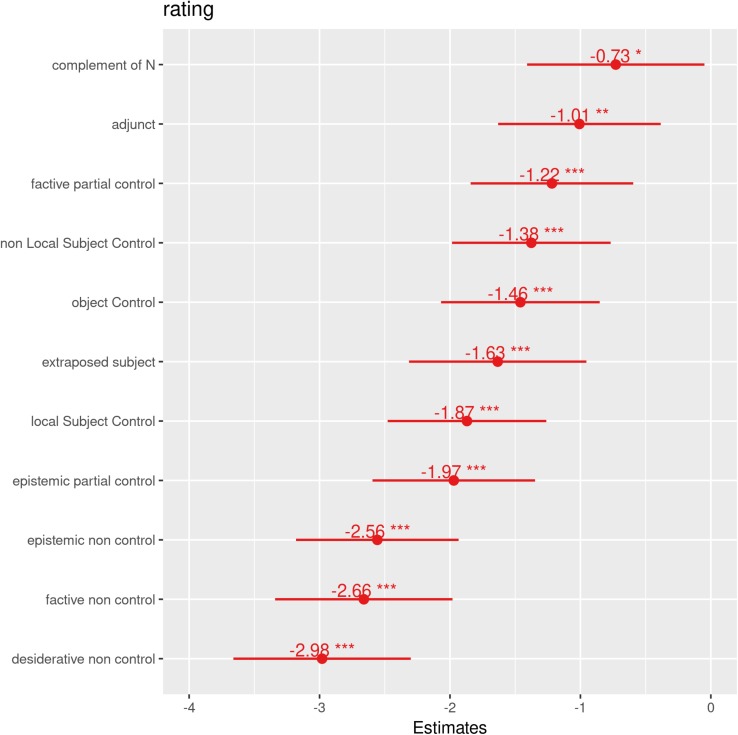
The fixed effects in the final model that do not participate in the three-way interaction, ordered by the estimates (the figure was produced using the sjPlot package, Lüdecke, 2018).